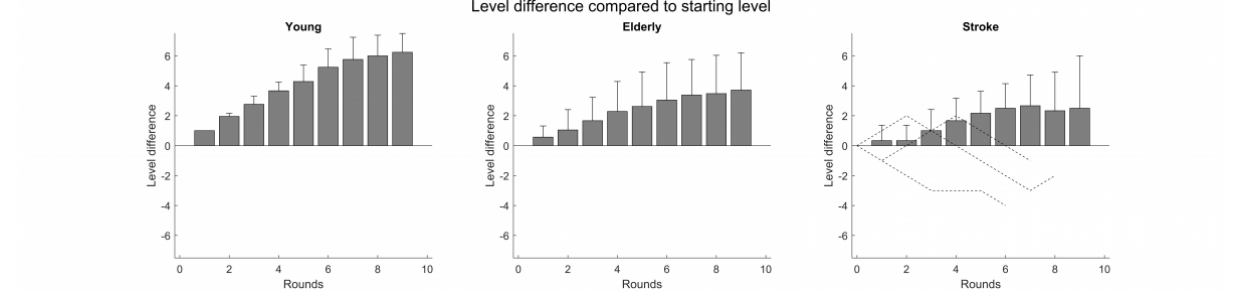
Figure 4. Level difference (and standard error) in the number of levels over the round compared to the starting level. In the neglect-group for the bars, only the 6 patients that played for 10 rounds were included. The raw values are included for the other 3 patients. The level difference is the mean of the difference between the level in round x minus the starting